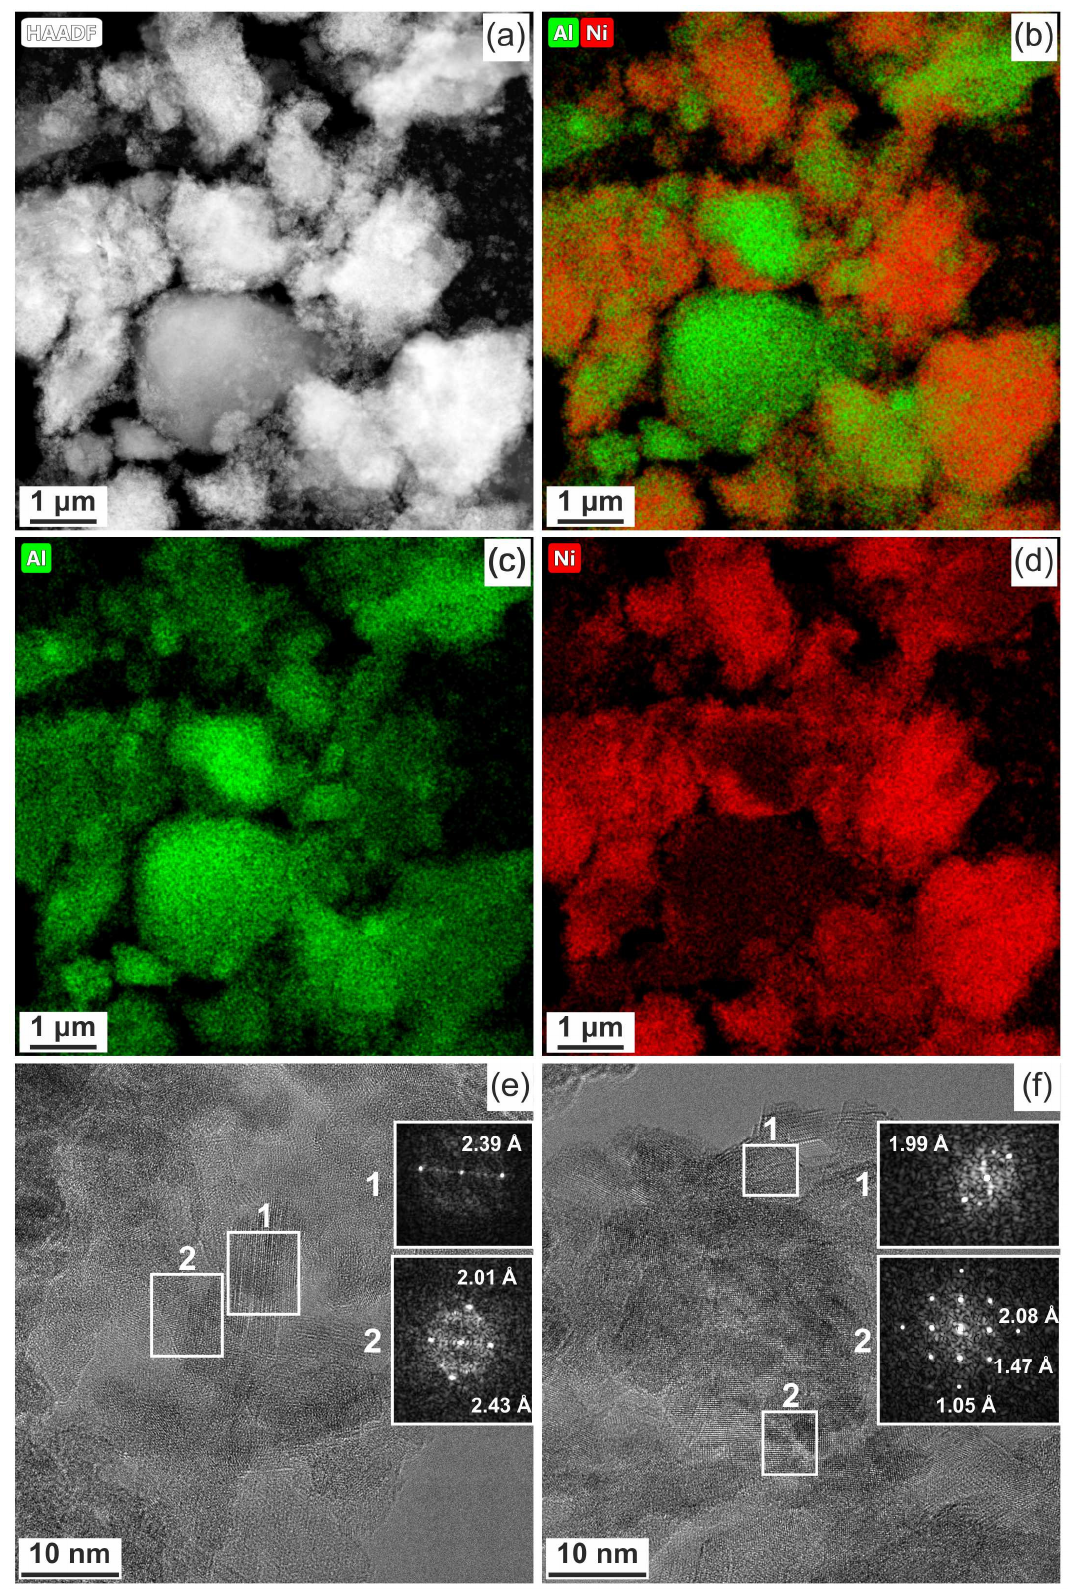
Figure 7. NIAP-07-01 catalyst: ( a – d ) compositional elemental mapping and ( e , f ) fast Fourier transform (FFT) patterns are calculated from the TEM image of individual particles.